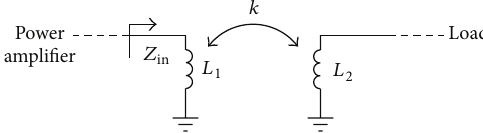
Figure 1: Inductive link schematic.